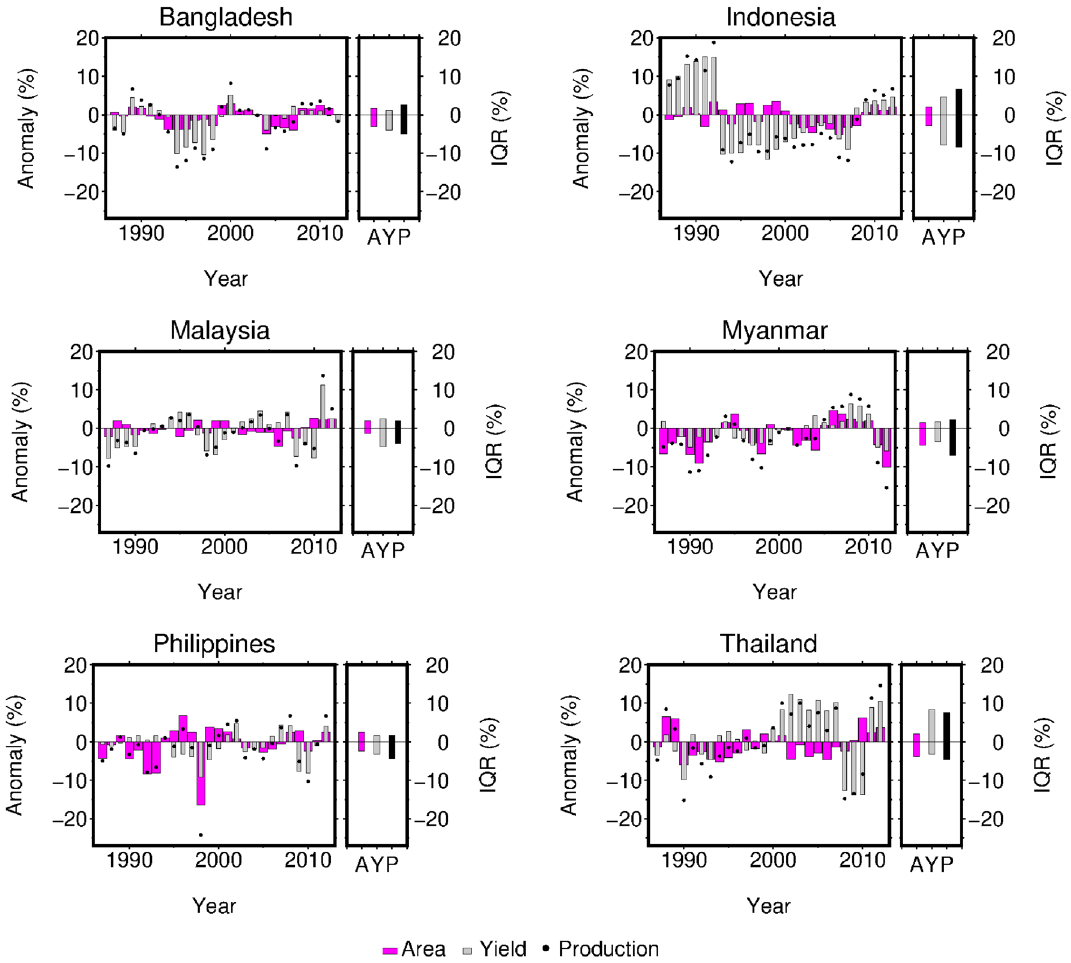
Figure 2. Reported anomalies of rice area, yield, and production. Inter-quantile ranges (IQR) are presented for area (A), yield (Y), and production